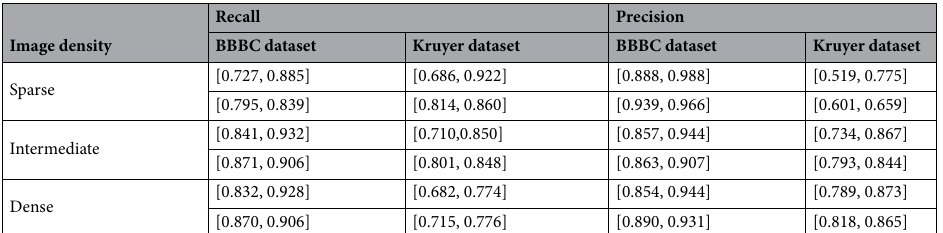
Table 2. Confidence intervals of recall and precision rates on the BBBC and Kruyer datasets using our YOLO- based algorithm. Each table cell reports the confidence intervals calculated using exact binomial method (top) and bootstrapping